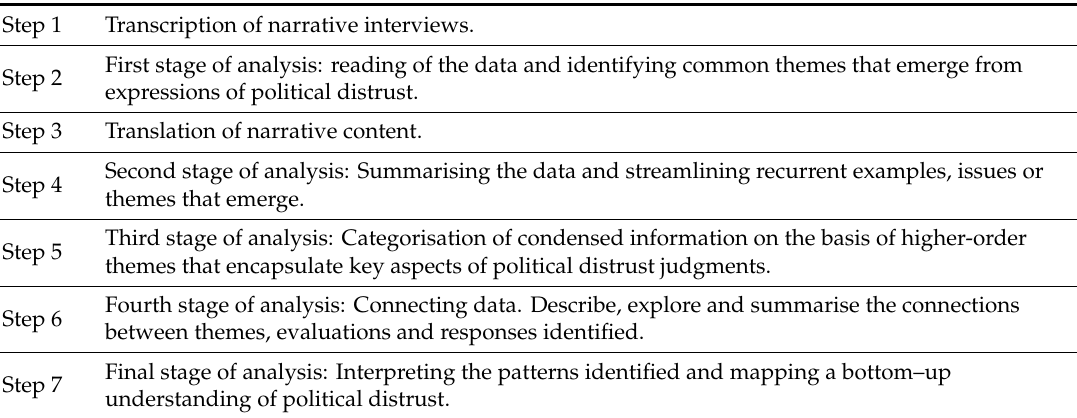
Table 2. Seven steps of narrative content